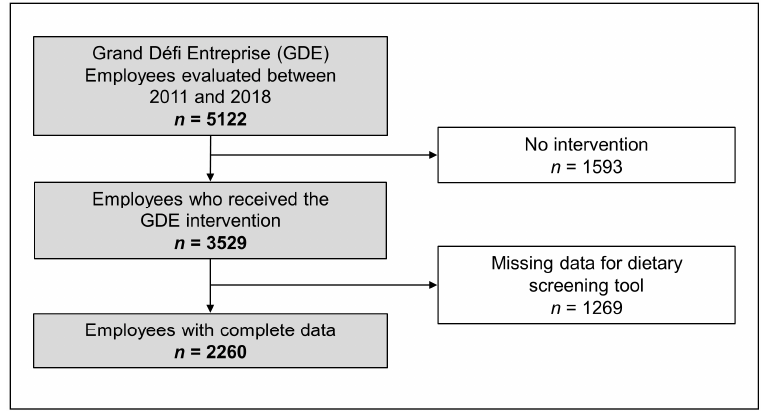
Figure 1. Flowchart of participants and reasons for exclusion for the present analyses.